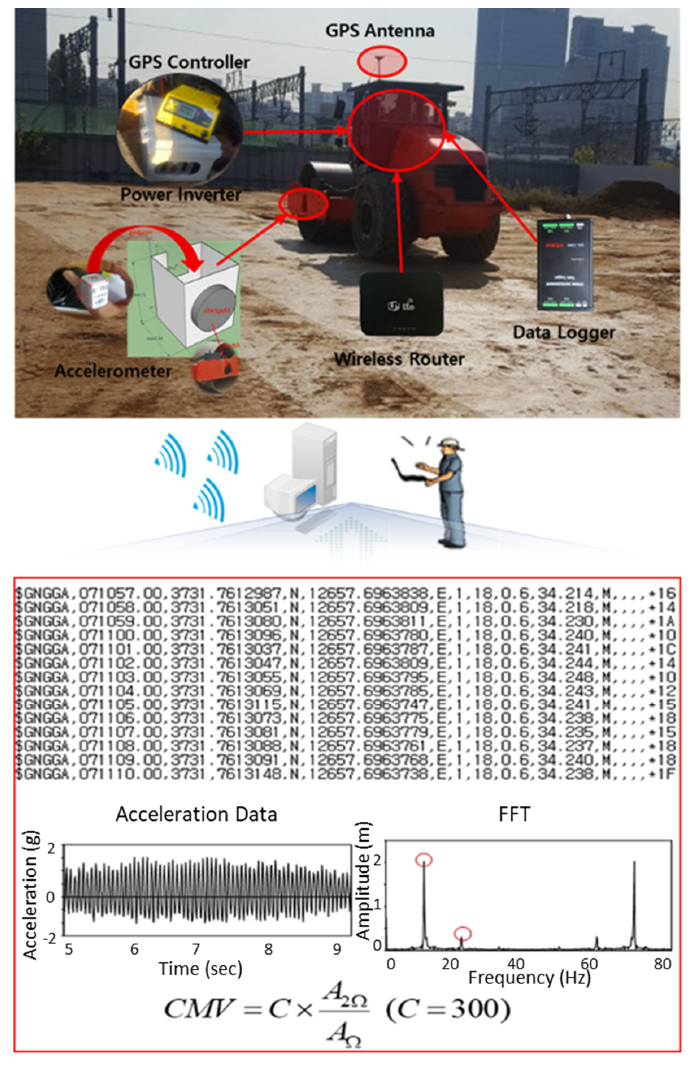
Figure 2. System hardware of the IC roller. Table 1. GGA data details and format.